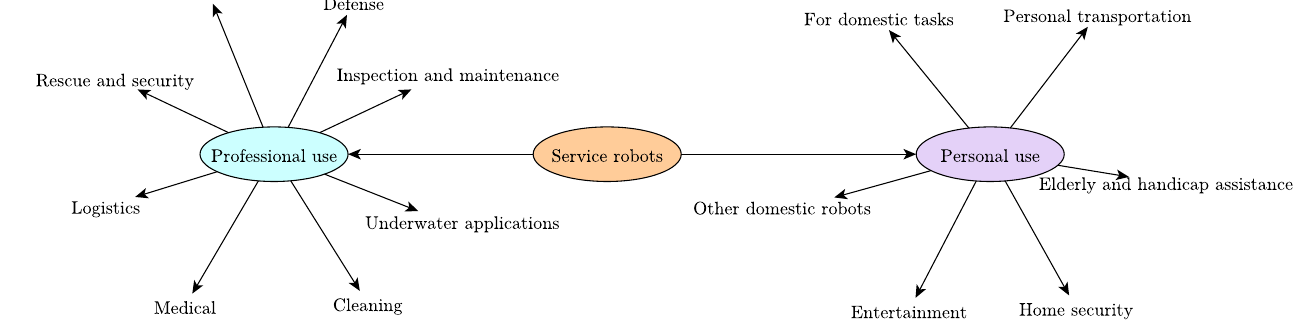
Figure 2. Taxonomy of service robots as proposed by the ISO 8373:2012.